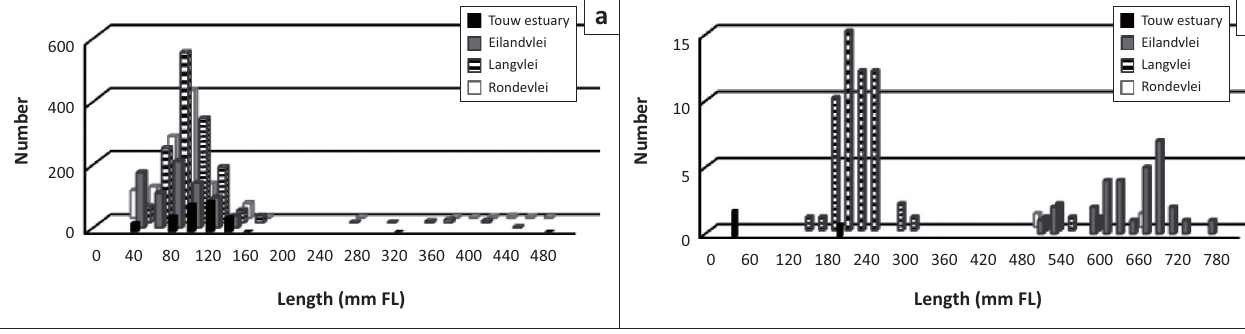
FIGURE 5: Length frequency of (a) Oreochromis mossambicus and (b) Cyprinus carpio captured in the Wilderness Lakes System between April 2010 and May